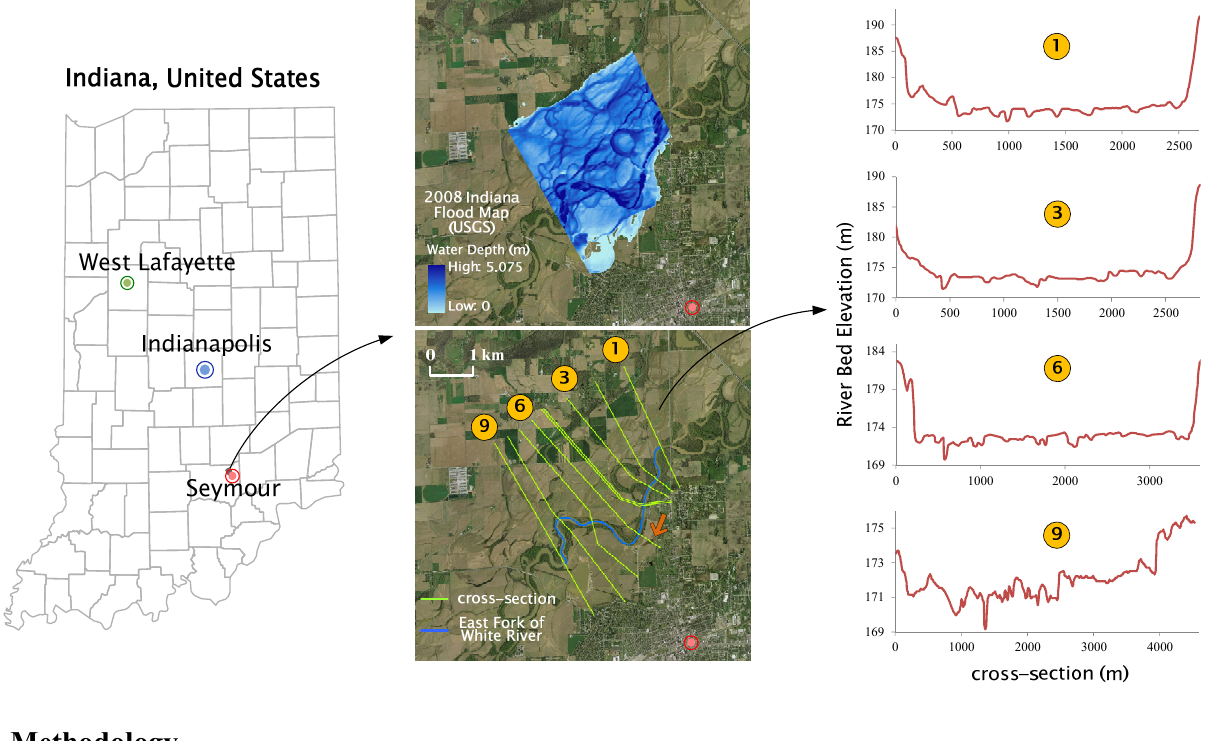
Figure 2. Study area (East Fork of the White River, near Seymour,